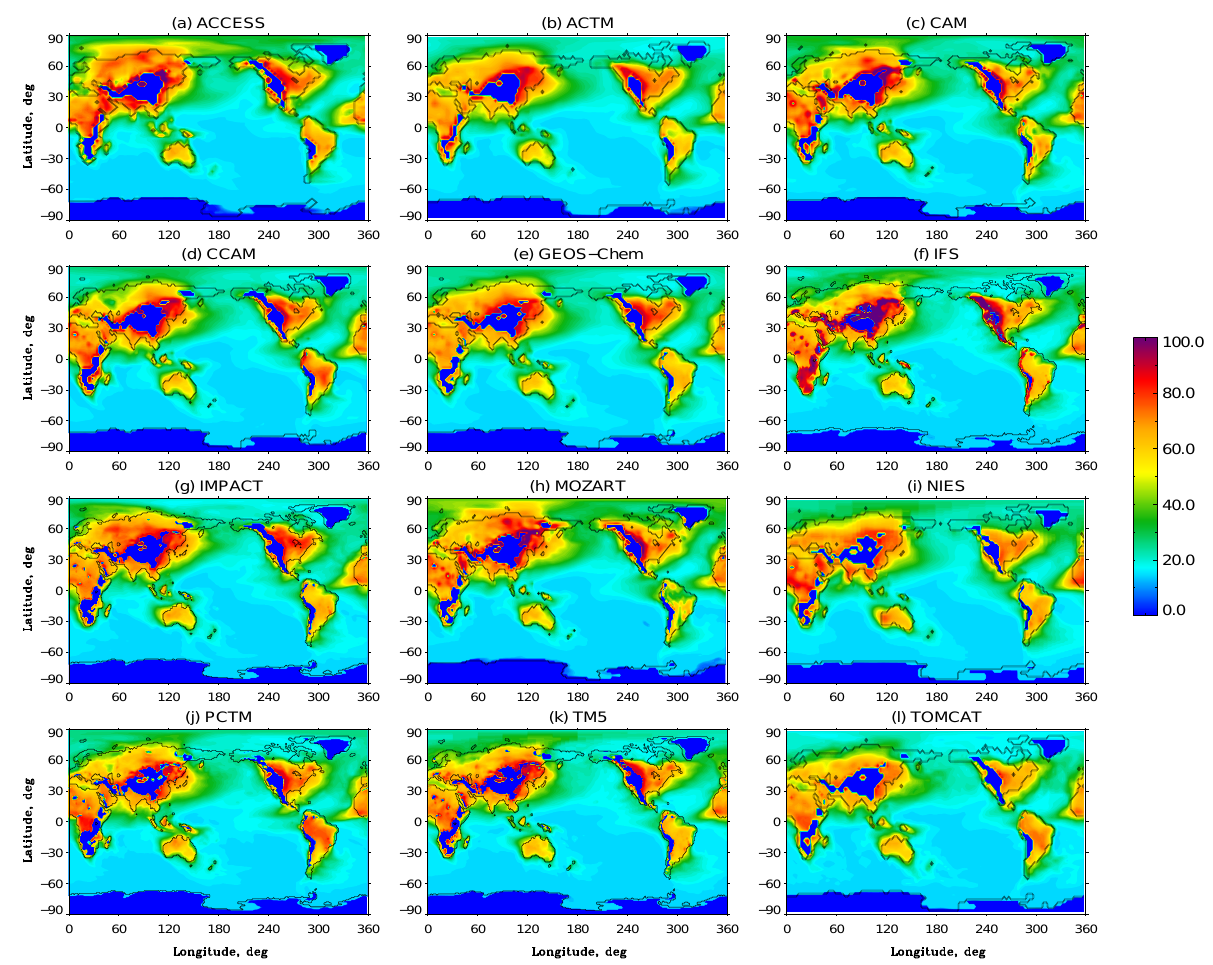
Fig. 4. Longitude-latitude distributions of 222 Rn concentrations (10 − 21 molmol − 1 ) at 900hPa during January as simulated by the eleven TransCom-CH4 models: (a) ACCESS, (b) ACTM, (c) CAM, (d) CCAM, (e) GEOS-Chem, (f) IFS, (g) IMPACT, (h) MOZART, (i) NIES08i, (j) PCTM, (k) TM5 and (l)